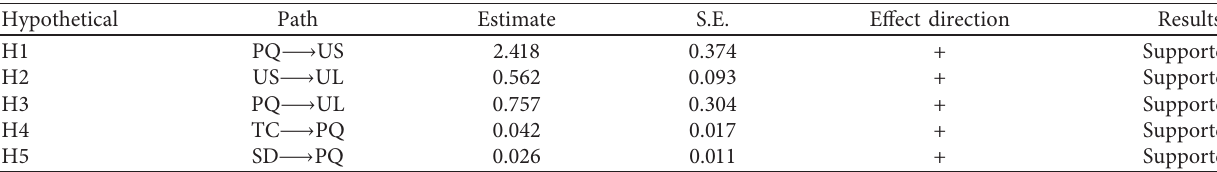
Table 7: Results of the structural